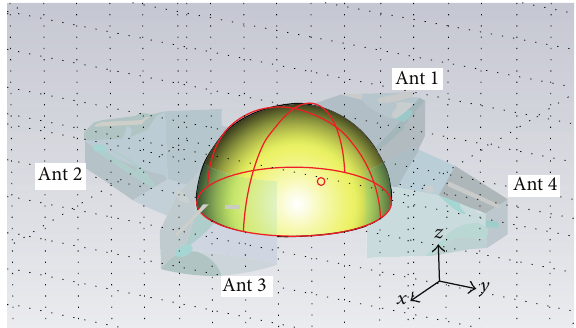
Figure 4: Breast model with tumour constructed in